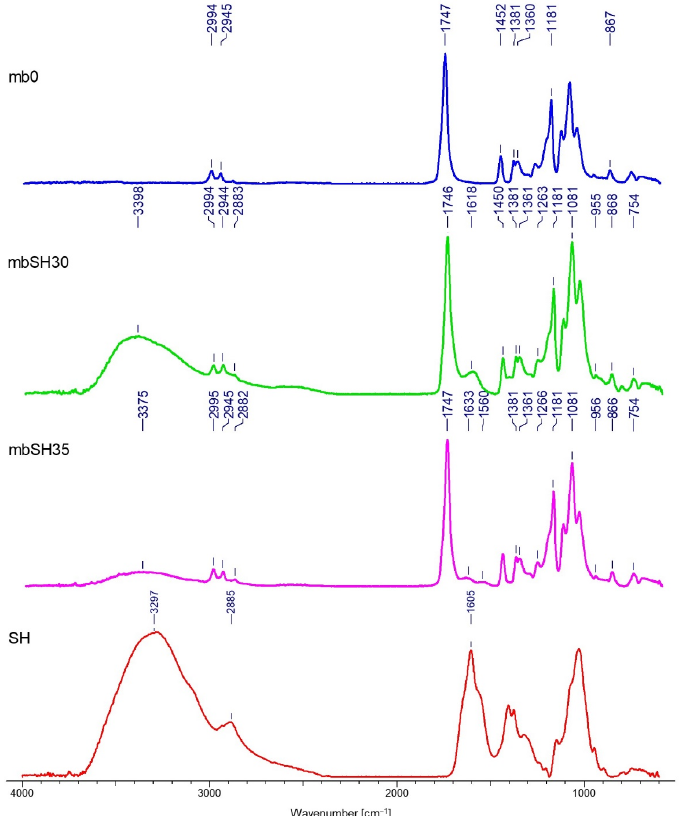
Figure 12. FTIR spectra of the melt-blown PLA nonwoven fabrics with deposition of the sodium hyaluronate layer (SH): mb0—reference sample (melt-blown PLA nonwoven); SA—powder of sodium hyaluronate.